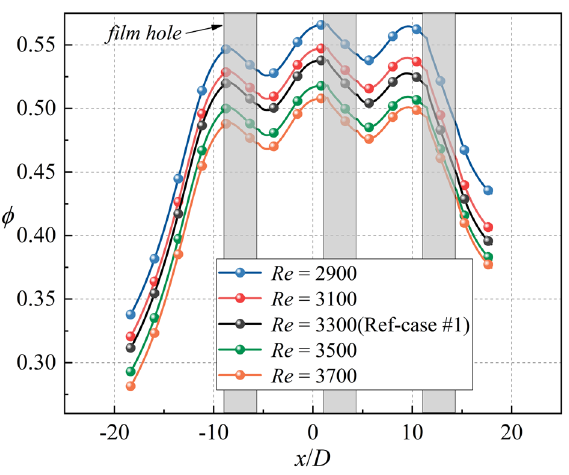
Figure 16. Laterally-averaged overall cooling effectiveness of film hole models with different Reynolds numbers.